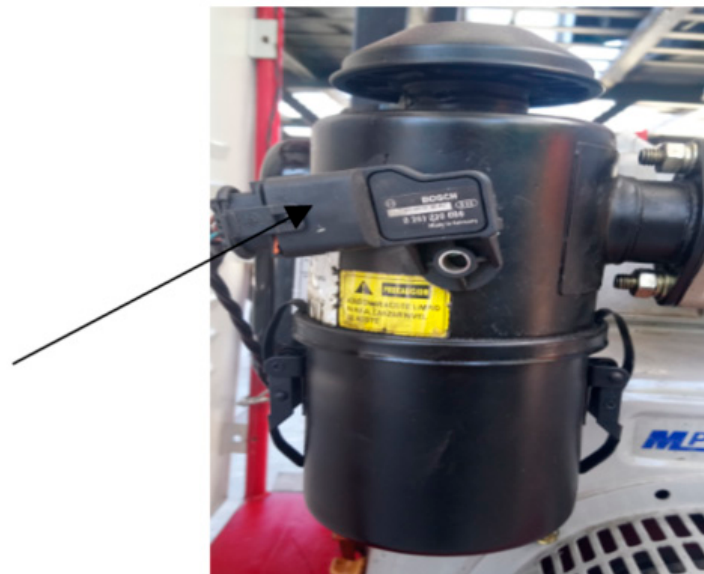
Figure 3. Air pressure sensor placed in the engine air filter.